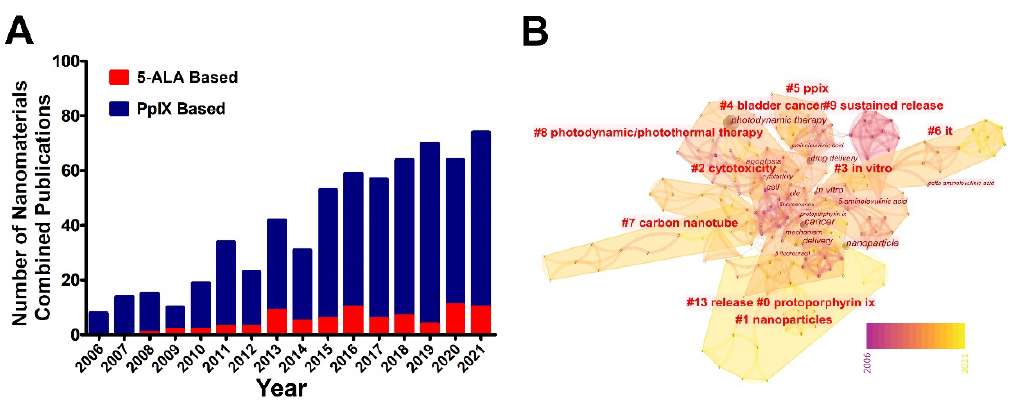
Figure 6. Key information for nanomaterials combined 5-ALA research. ( A ) The trends of 5-ALA- based and PpIX-based annual publication numbers. Data were collected in the retrieval formula of TI = (*aminolevulinic acid OR 5 ALA) and TS = (nano*), and TS = (Protoporphyrin ix OR PpIX) and TS = (nano*) respectively, publications were articles only. ( B ) Cluster analysis diagram of nano- materials combined 5-ALA research by CiteSpace.